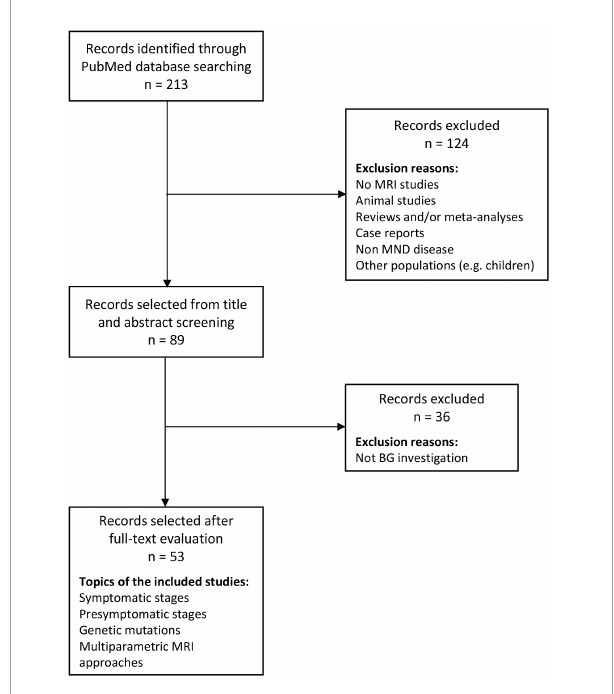
FIGURE1 Flow chart of the reviewing process. MND, motor neuron disorders; MRI, magnetic resonance imaging.